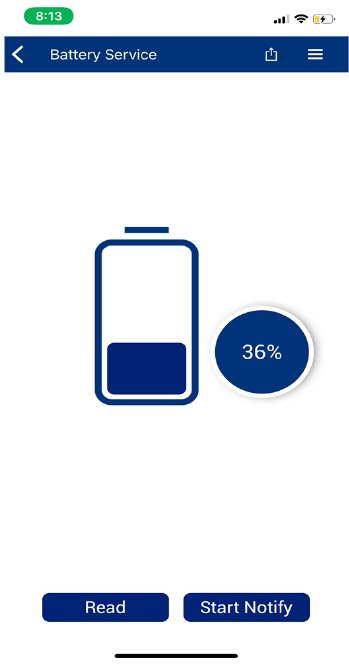
Figure 16. CySmart Data Characteristics (Battery Service).